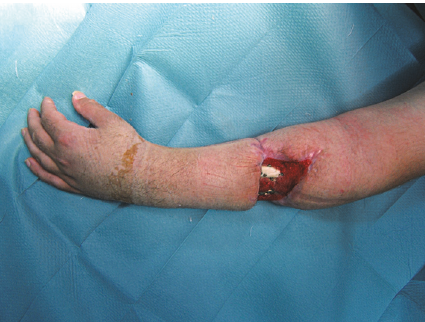
Figure 1: After thorough surgical debridement, a considerable soft tissue defect was created and bone was left